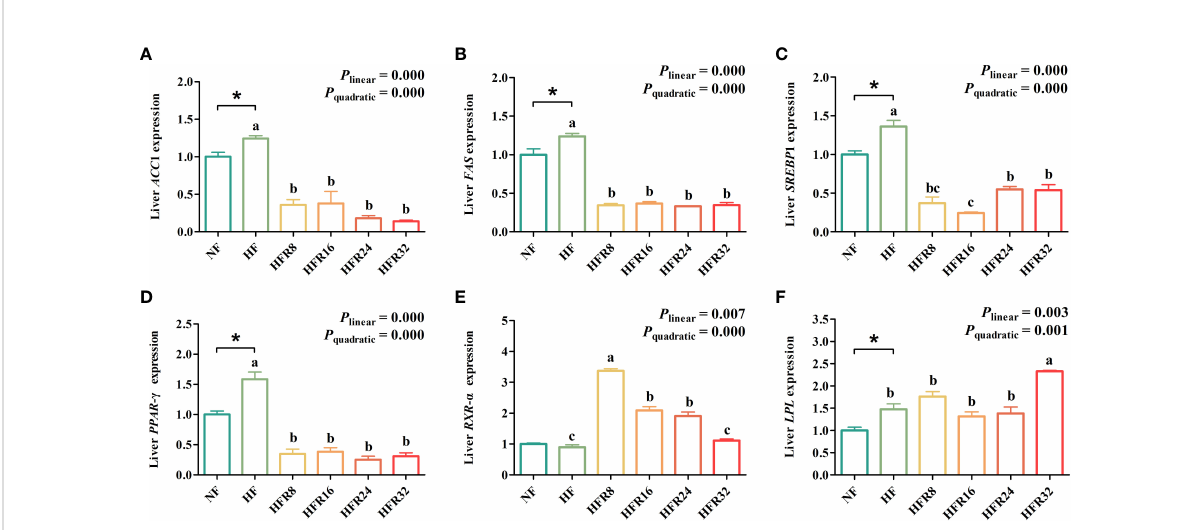
FIGURE 4 Effects of resveratrol supplementation on the hepatic lipid metabolism-related gene expression in common carp ( Cyprinus carpio ). de novo lipogenesis-related genes include (A) acetyl-CoA carboxylase 1 (ACC1), (B) fatty acid synthase (FAS), and (C) peroxisome and sterol regulatory element binding protein 1 (SREBP1). Fatty acid b -oxidation-related genes include (D) proliferator activated receptor g (PPAR- g ) and (E) retinoid X receptor a (RXR- a ). Fatty acid uptake-related gene includes (F) lipase (LPL). Data are presented as means ± SEM. “ * ” represented statistical difference between the NF group and the HF group using student ’ s t-test (* P < 0.05). “ abc ” represented statistical difference among different RSV levels in the HF diet. P -values indicated a linear and quadratic to dietary RSV levels using orthogonal polynomial analysis. Bars with different superscripts are statistically different ( P < 0.05, n =